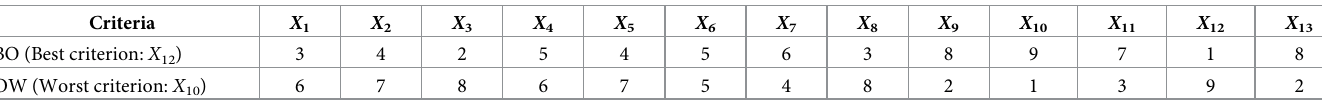
(M), good(G), and very good(VG). Each of these linguistic variables is represented by a trian- gular fuzzy number and these numbers are (0, 0, 0.2), (0.1, 0.3, 0.4), (0.3, 0.5, 0.7), (0.6, 0.7, 0.9), (0.8, 1.0, 1.0), respectively. For the attributes described by hesitant fuzzy linguistic term sets, a five-point linguistic scale is constructed, which is S = {s normal, s = small, s = very small}. Depending on the data of historical cases ( Z 1 2 and target case( C o ), the initial decision matrix is shown in Table 2. Based on the reference comparisons in BWM, the priorities of the criteria are determined as numbers between 1 and 9. Table 3 shows the decision-maker preferences. The Decision-making process is as follows.